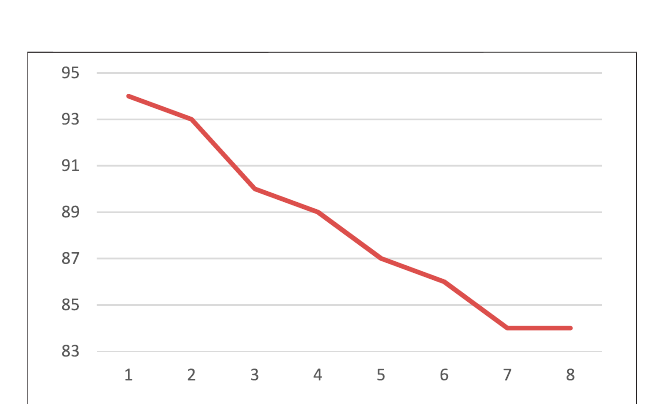
FIGURE 4 | Investigation of reusability of the MIL-101(Cr) catalyst within eight